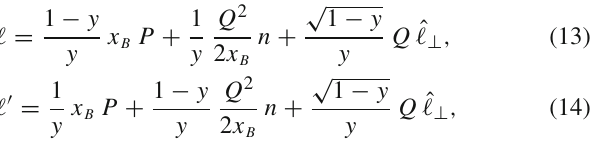
Fig. 1 Leading order diagram for the process γ ∗ ( q ) + g ( p ) → Q ( P Q ) , with Q = J /ψ or ϒ . The crossed diagram, in which the directions of the arrows are reversed, is not shown. Only the color-octet ( 8 ) ( 8 ) configurations 1 S , 3 P with J = 0 , 1 , 2, contribute, as it turns out J 0 from the calculation described in Appendix A